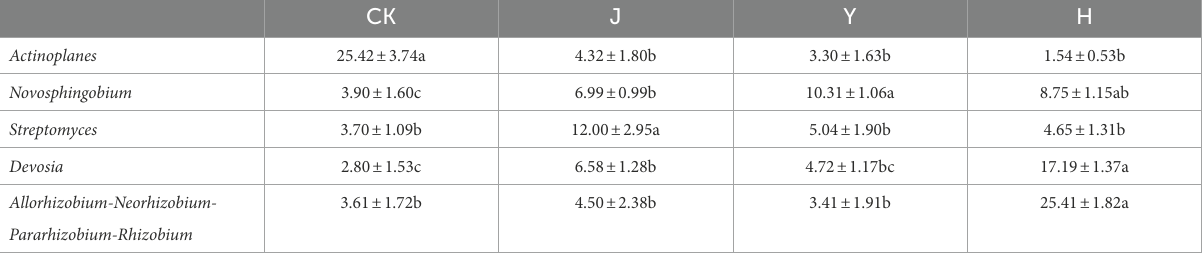
TABLE 14 Comparison of major bacterial community composition of soybean-potted root at the genus